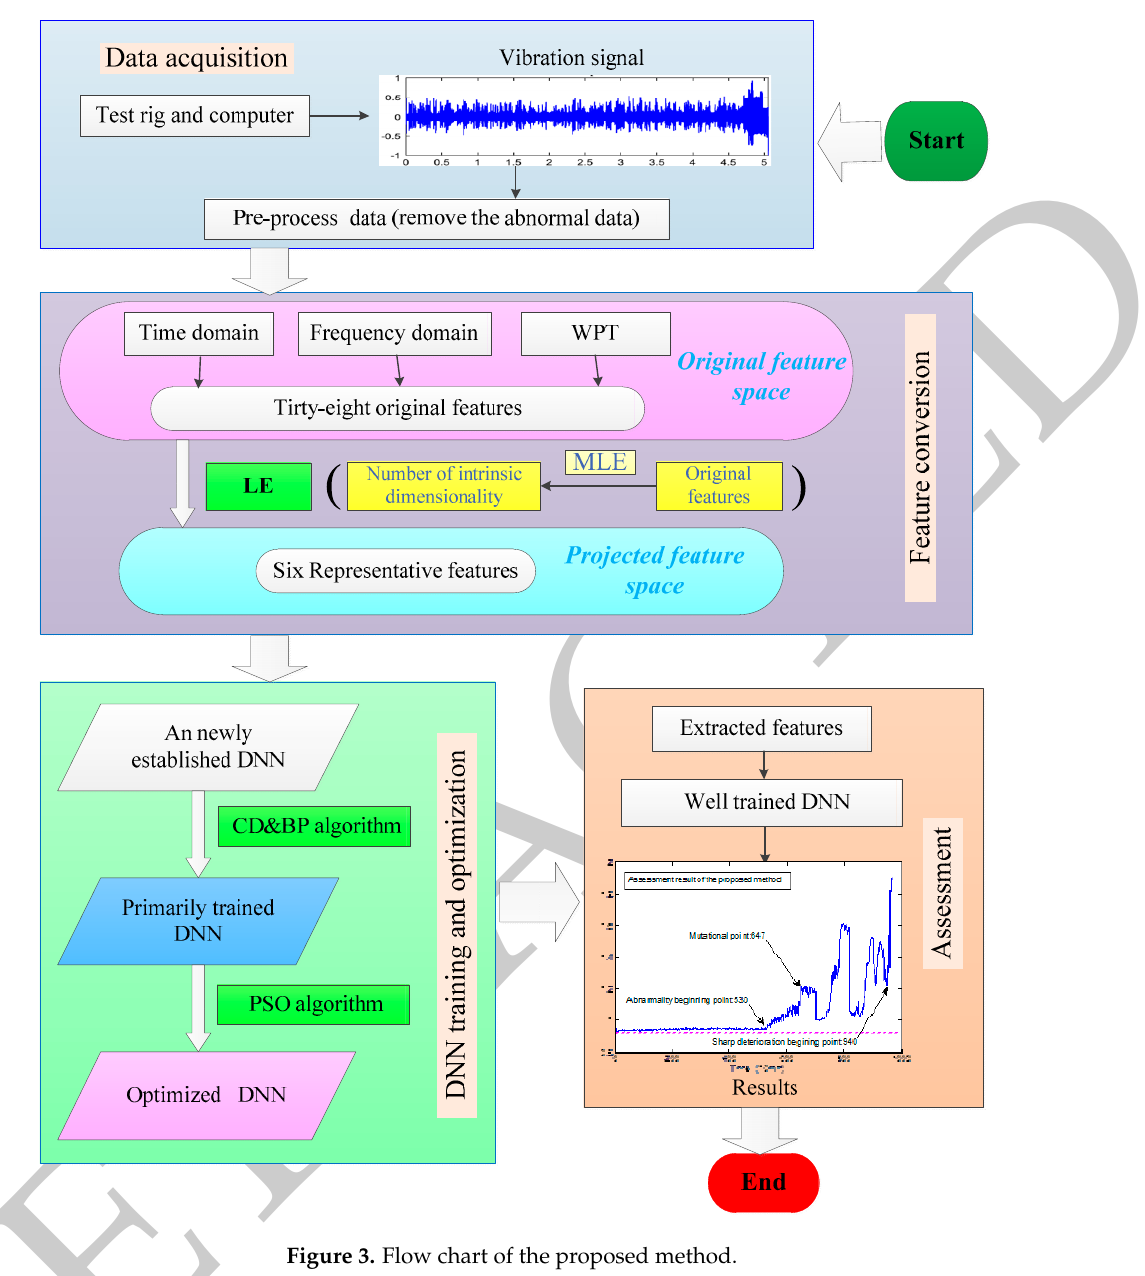
Figure 3. Flow chart of the proposed method.